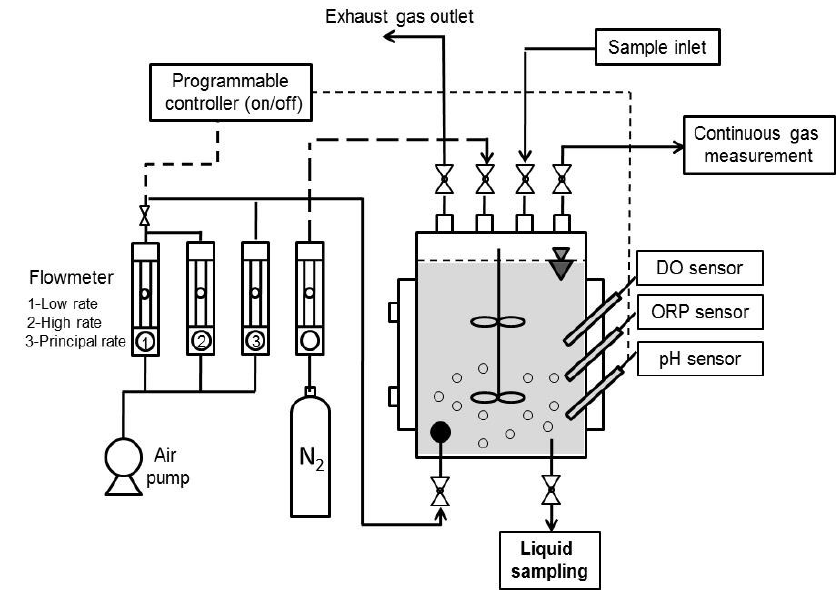
Fig 1. Schematic of the laboratory-scale incubation